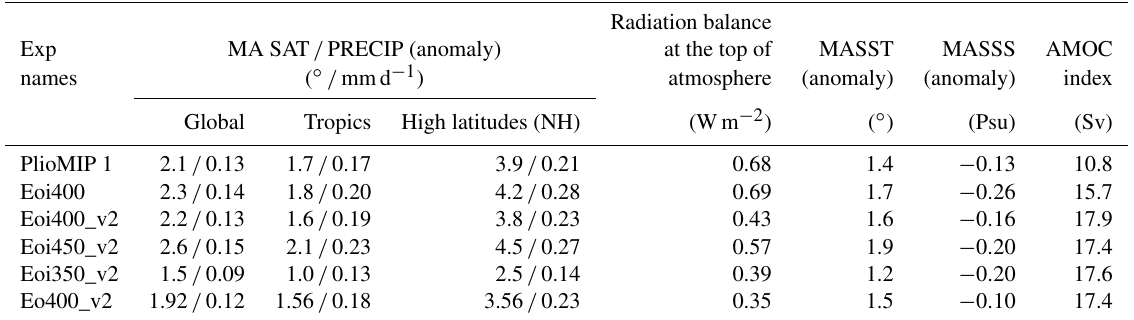
Table 3. Diagnostics for each experiment. The anomalies are computed against the PI controls corresponding to the version of the numerical model employed. MA: mean annual; PRECIP: precipitation; SST: sea surface temperature; SSS: sea surface salinity; AMOC: the Atlantic Meridional Overturning